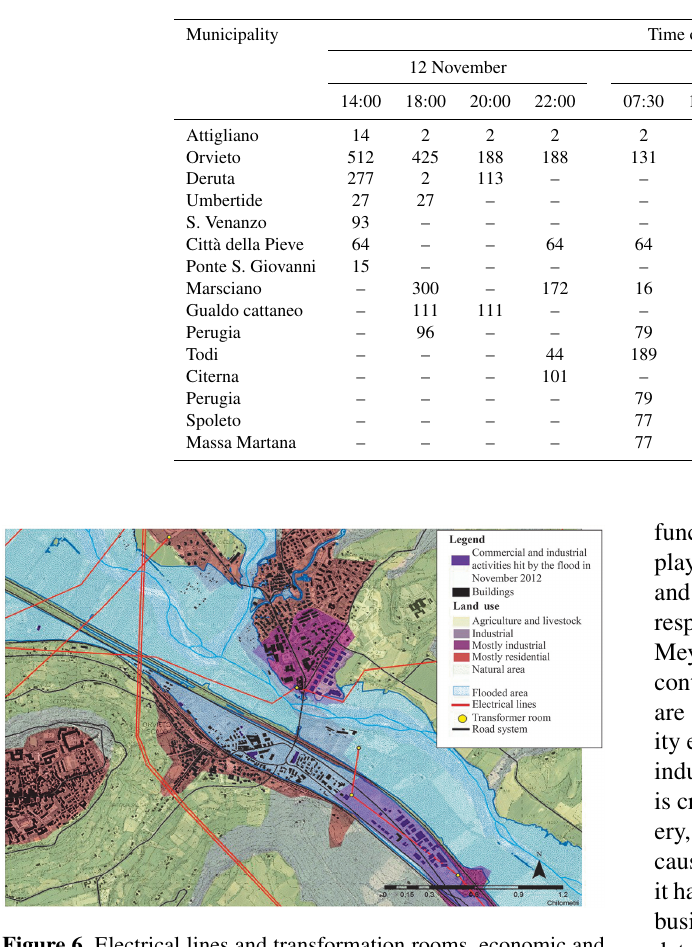
Figure 6. Electrical lines and transformation rooms, economic and industrial activities hit by the November 2012 flood in